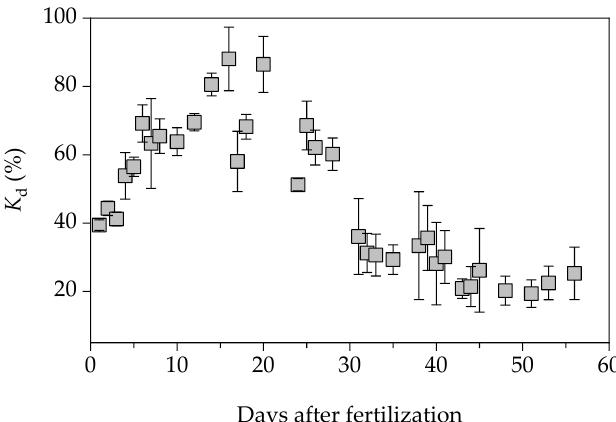
Figure 5. Contributions of nitrate reduction in denitrification ( K d) to the total soil N 2 emissions. The observational period and meaning of each error bar are found in the footnotes of Figures 2 and 3, respectively.